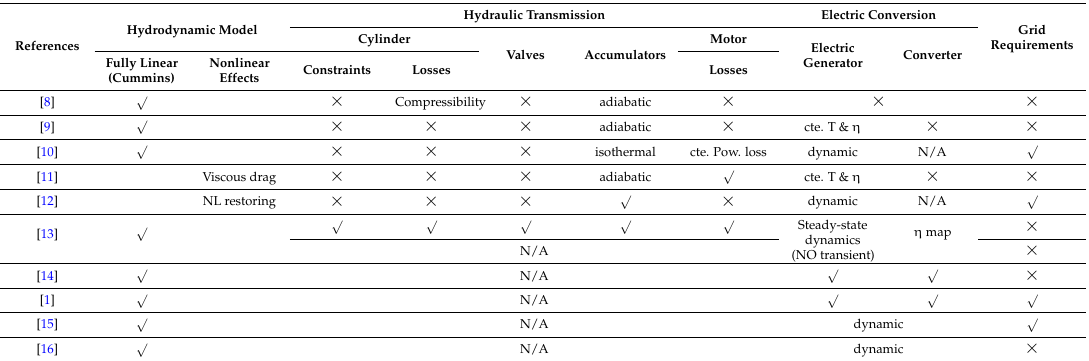
Table 1. Literature review summary table, showing essential control characteristics for wave-to-wire (W2W) models. The following abbreviations are used in the table above: N/A for not applicable, cte. for constant, T for torque and η for